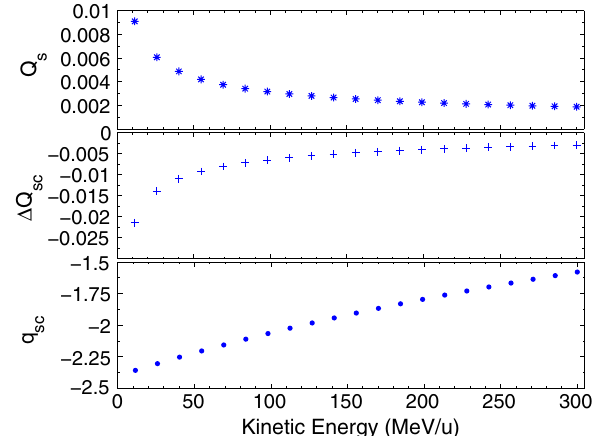
FIG. 25. Change in synchrotron tune and space charge tune shift on acceleration from injection to extraction for Ar 18 þ with 1 (cid:7) 10 10 particles. The estimated space charge parameter re-